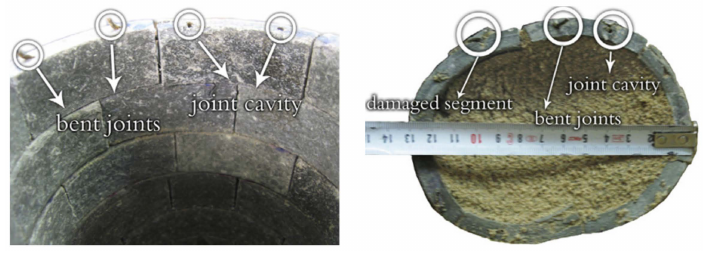
Figure 8. Model test results of the cross-fault segmental tunnel [25].